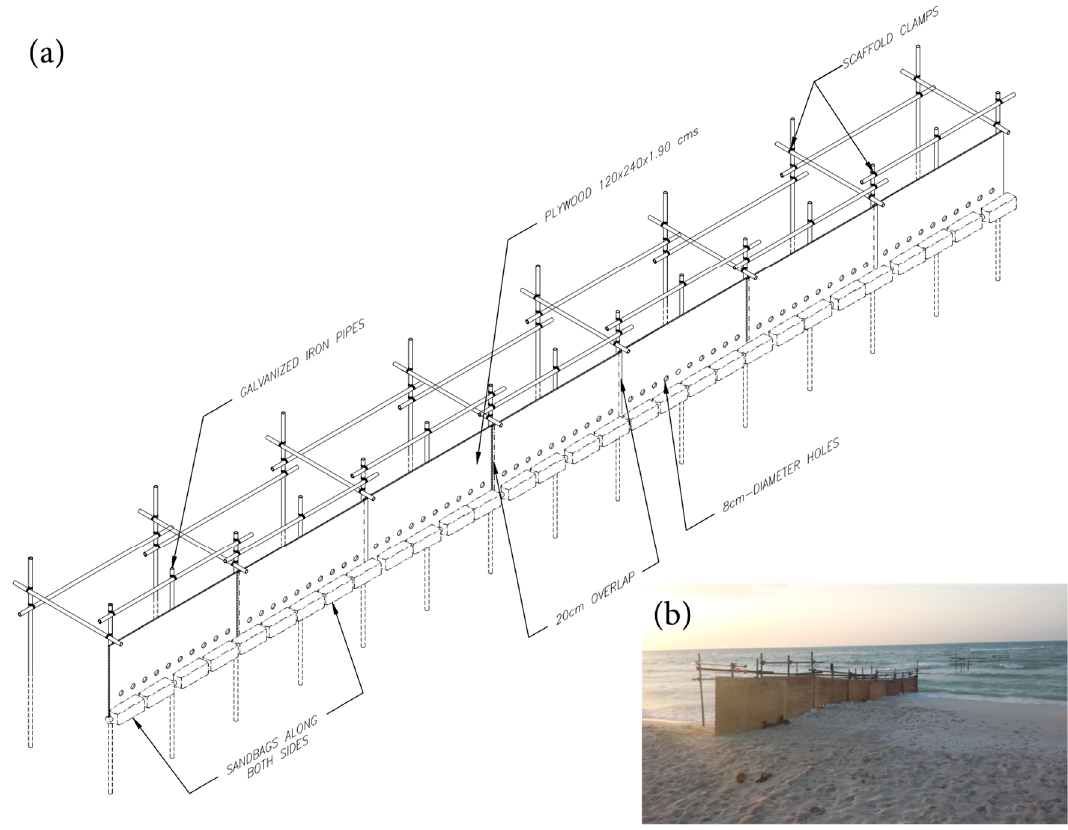
Figure 4. ( a ) Temporary groin design made of wood-sheets, lined with sand bags and a scaffold frame of iron pipes. ( b ) Picture of the shoreline perturbation 12-h after the groin deployment.